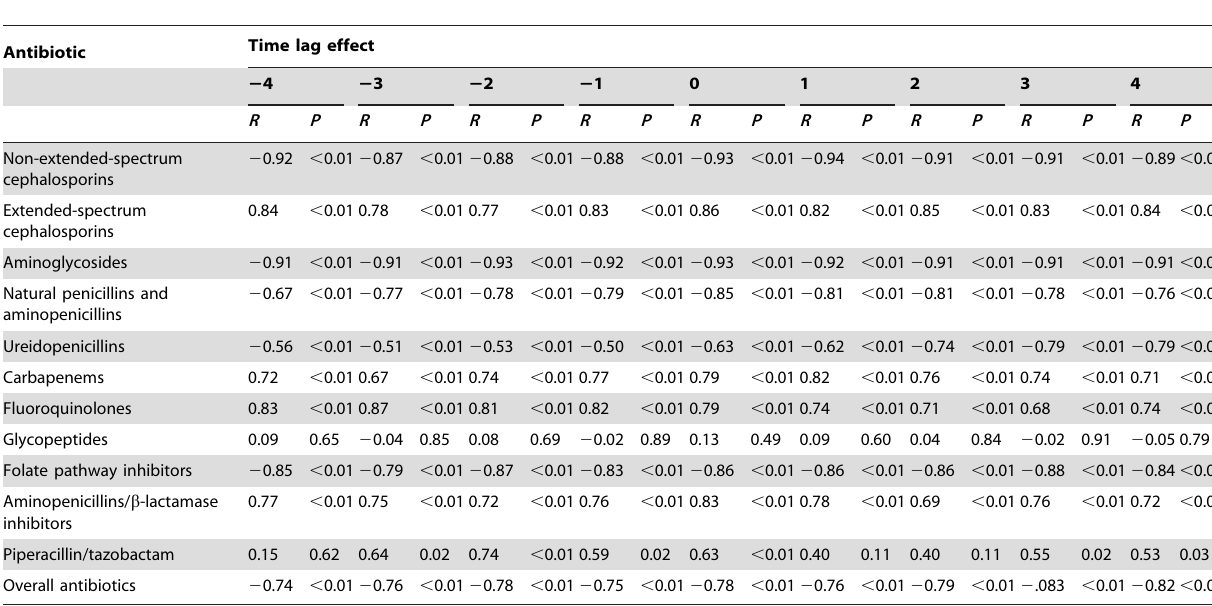
Table 3. Correlations of antibiotic consumptions and healthcare-associated infections caused by carbapenem-resistant Acinetobacter spp. per 1,000 patient-days per quarter (2002 to 2009) and time lag effects of antibiotic consumptions.